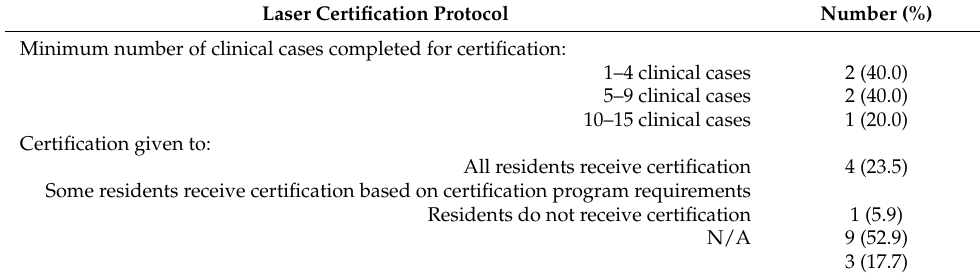
Table 4. Laser certification protocols followed in graduate periodontics programs in the U.S. and